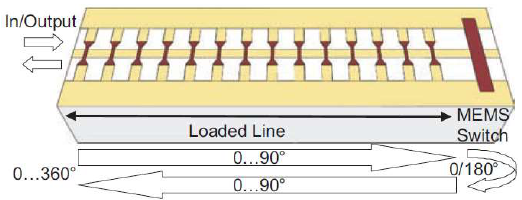
Figure 28. Principle of the reflection-type phase shifter with a 90°-loaded line phase shifter and a MicroElectroMechanical Systems (MEMS) switch at the end [267,268].